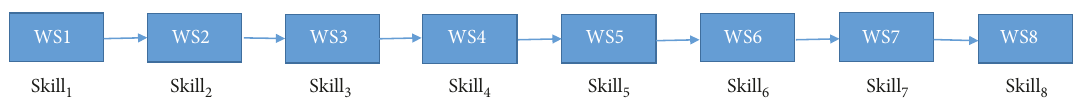
Figure 8: The layout of the fl ow-shop